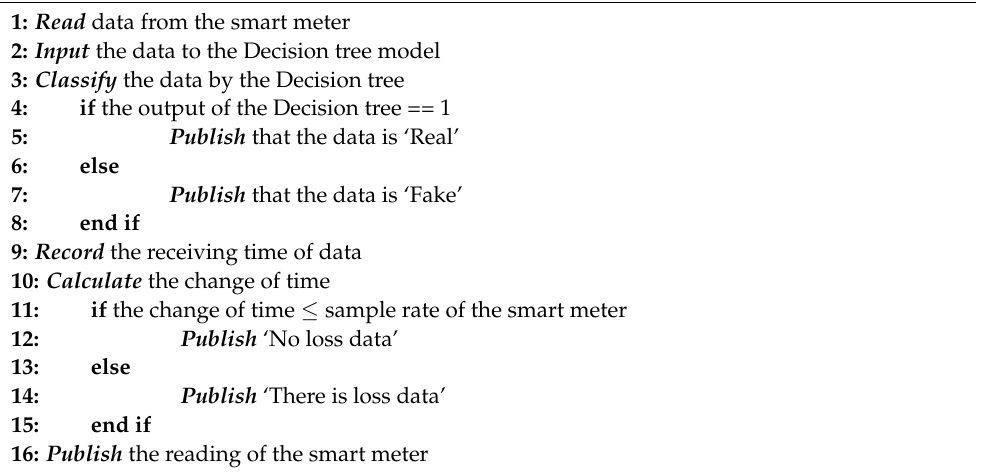
Algorithm 1 The pseudo-code of data acquisition, validation, and visualization